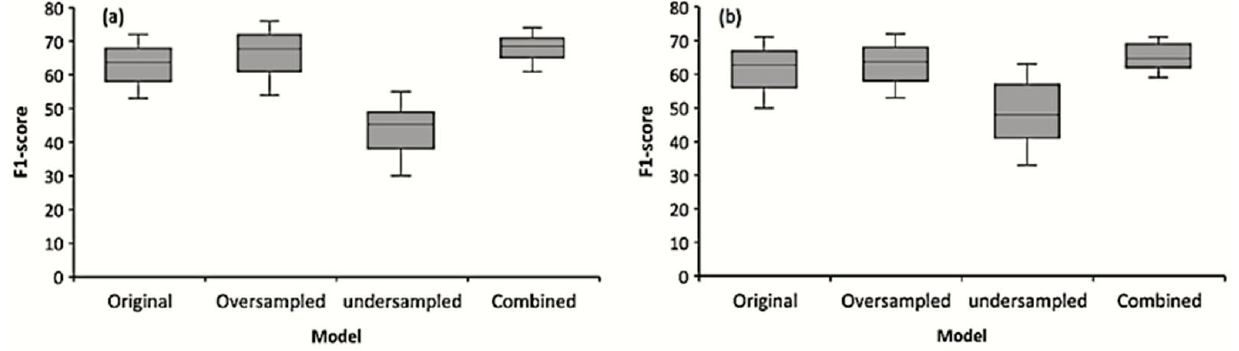
Figure 9. Species-level F1-score for the combined oversampling and undersampling technique: ( a ) RF; ( b ) SVM.